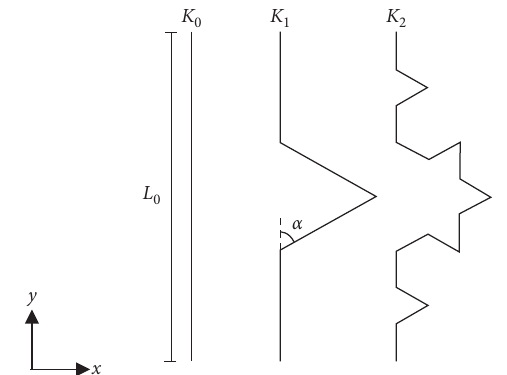
Figure 2: Koch fractal monopole from zero to second iteration.